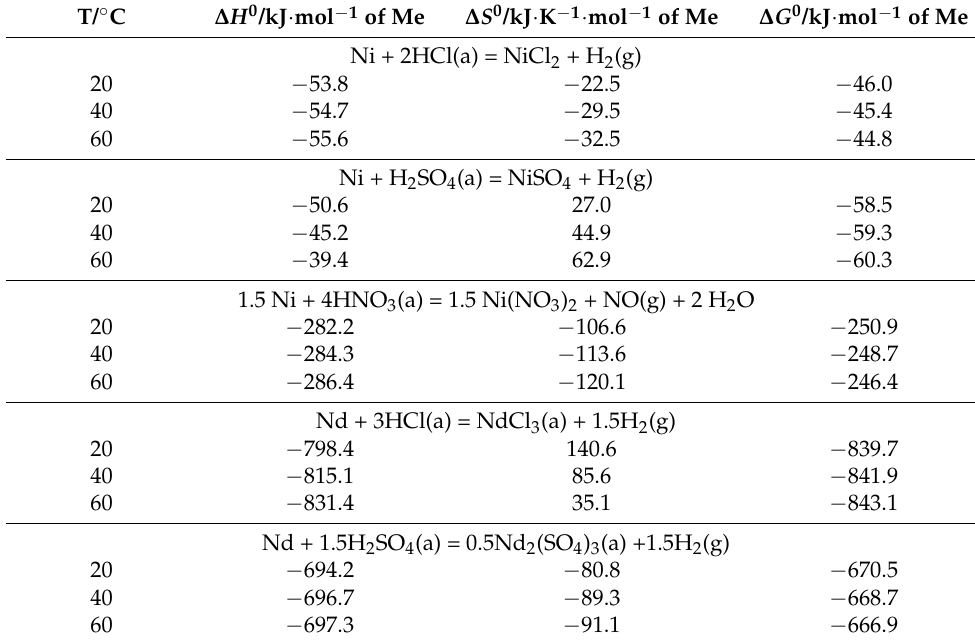
Table 4. Thermodynamic data for dissolution of nickel in HCl, H 2 SO 4 and HNO 3 as well as for Nd in HCl and H 2 SO 4 .The values were calculated per 1 mol of metal